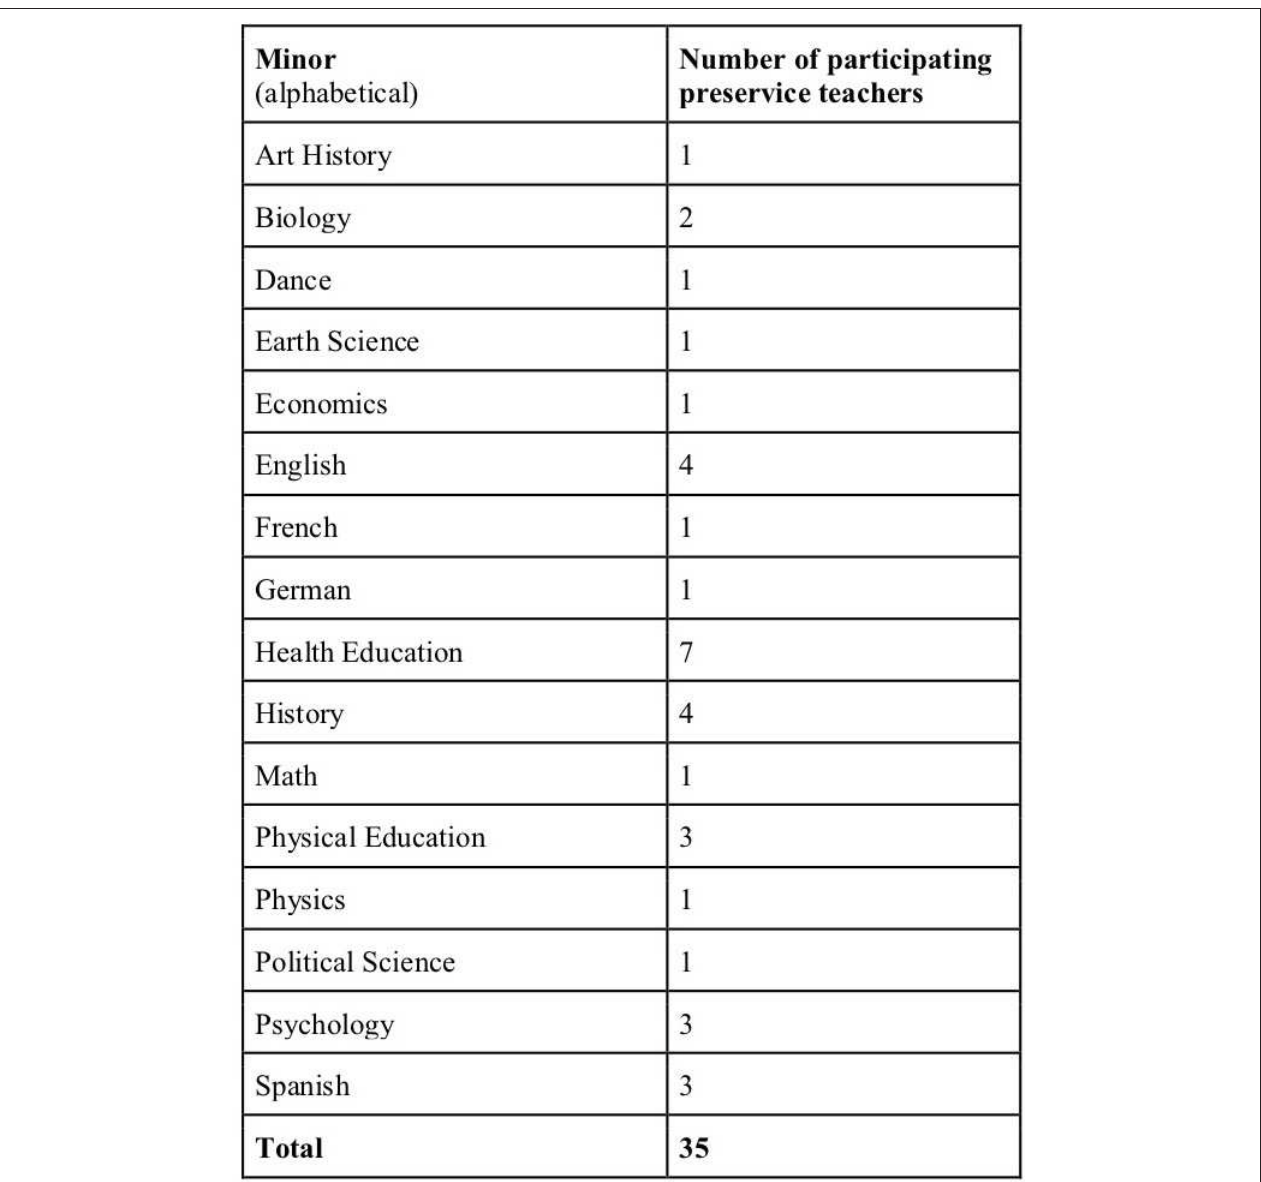
FIGURE 2 | Participating preservice teachers’ minors (due to personal choice and/or state certification requirements, some participants had more than one minor and others had no